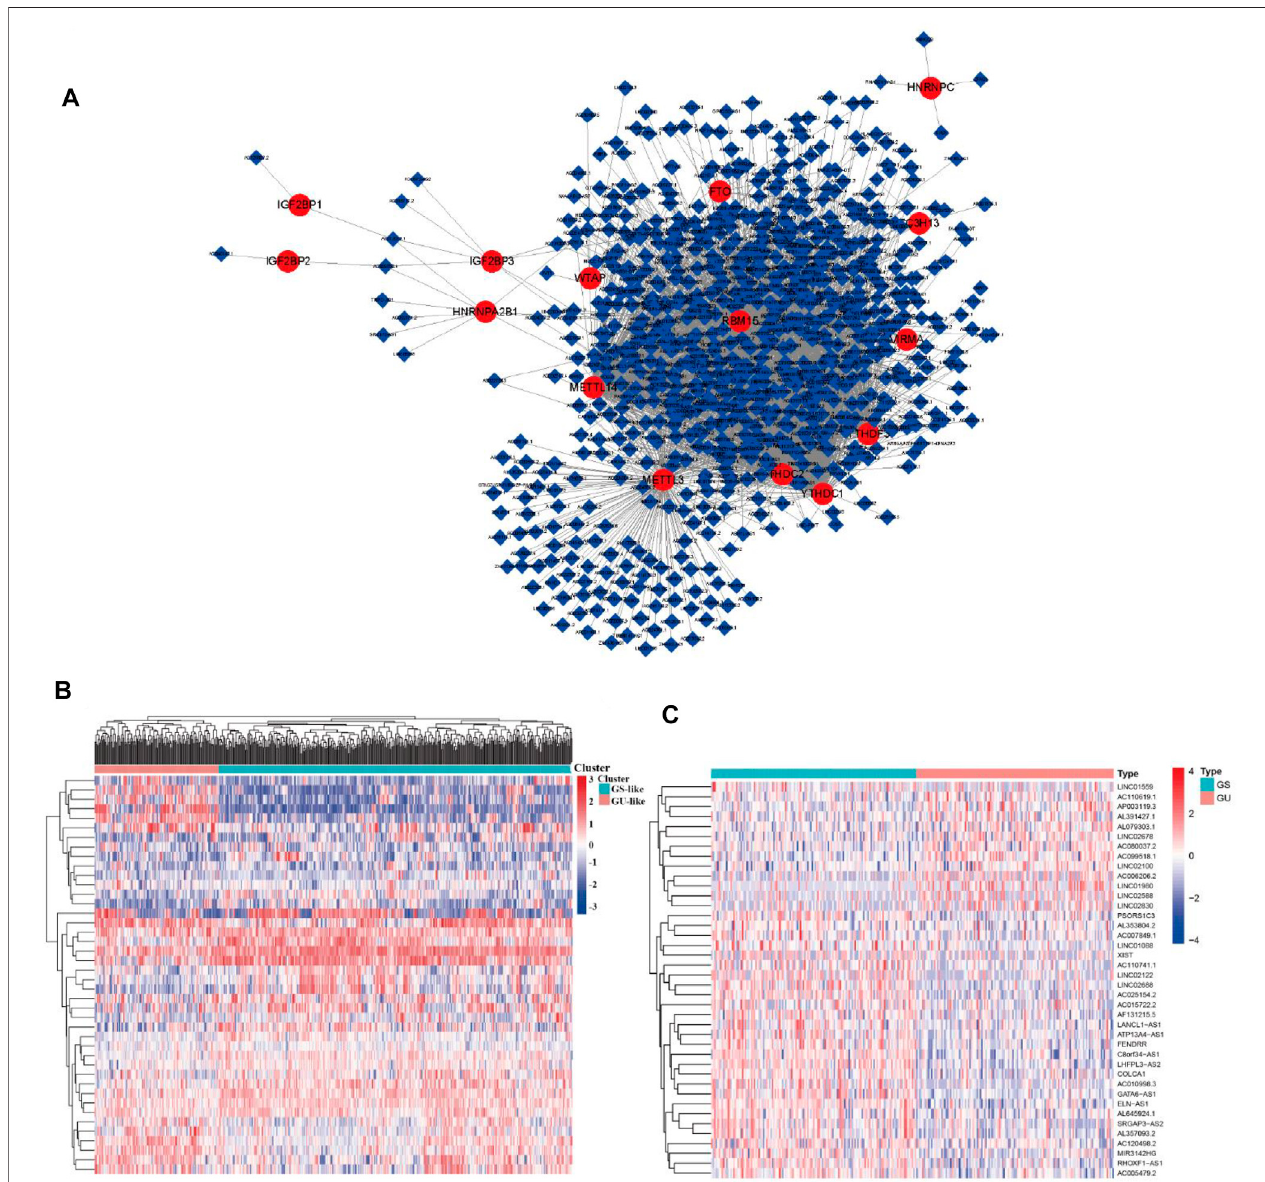
FIGURE 2 | m6A regulator – lncRNA coexpression network construction, differential analysis, and hierarchical cluster analyses in LUAD. (A) Coexpression network betweenm 6 Aregulatorsandm 6 A-relatedlncRNAs.Redcirclesindicatem6Aregulators;bluediamondsindicatem 6 A-relatedlncRNAs. (B) Heatmapshowingthetop20 upregulated and top 20 downregulated differentially expressed m 6 A-related lncRNAs between the GS-like group and GU-like group. (C) Hierarchical cluster analyses based on the expression of differentially expressed m 6 A-related lncRNAs.